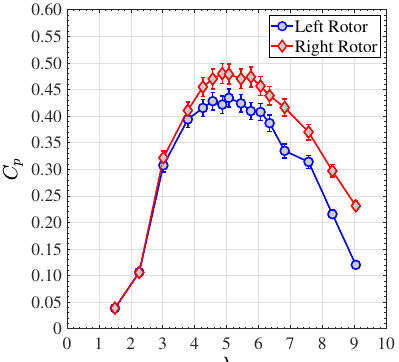
Figure 9. Calculated C p vs. λ (coefficient of power vs. tip-speed ratio) for the left (blue) and right (red) RM1 rotors. Vertical error bars represent mean C p value measurement uncertainty. Maximum C p occurs near λ ≈ 5.1 (right rotor C p = 0.48; left rotor C p = 0.43). Results have not been corrected for channel blockage; therefore, maximum C p may slightly decrease after blockage corrections have been